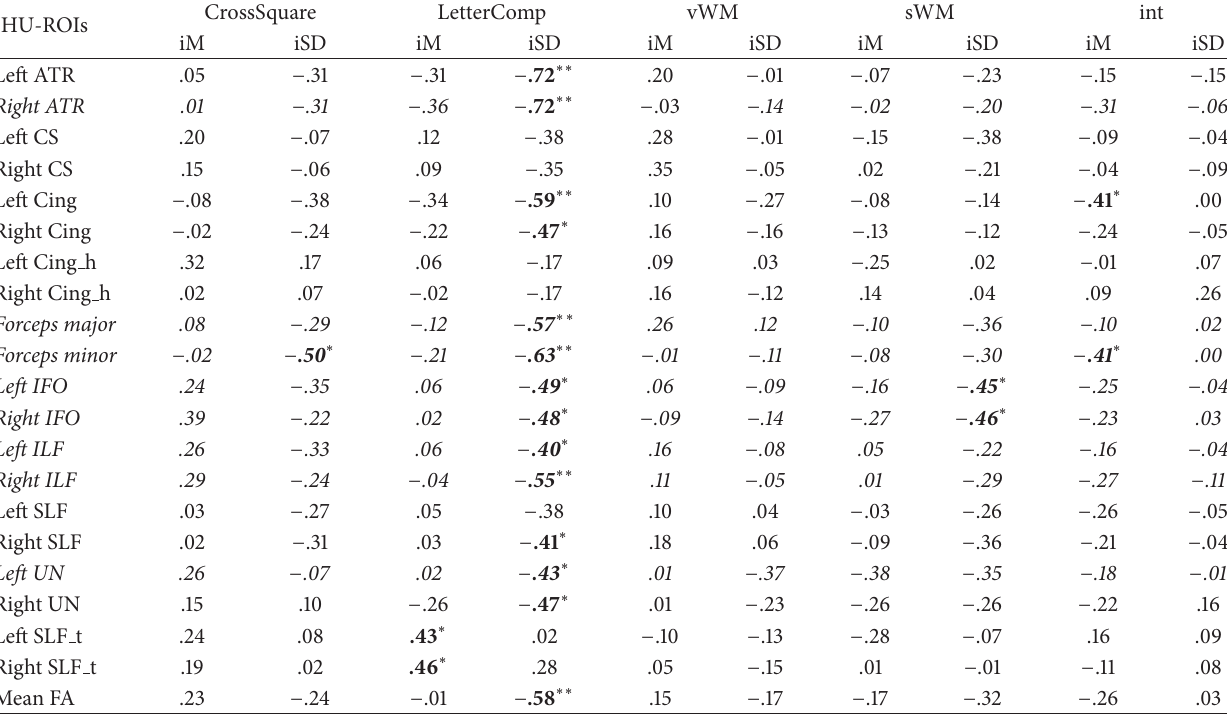
Table 3: Correlations between FA in the JHU-ROIs and cognitive